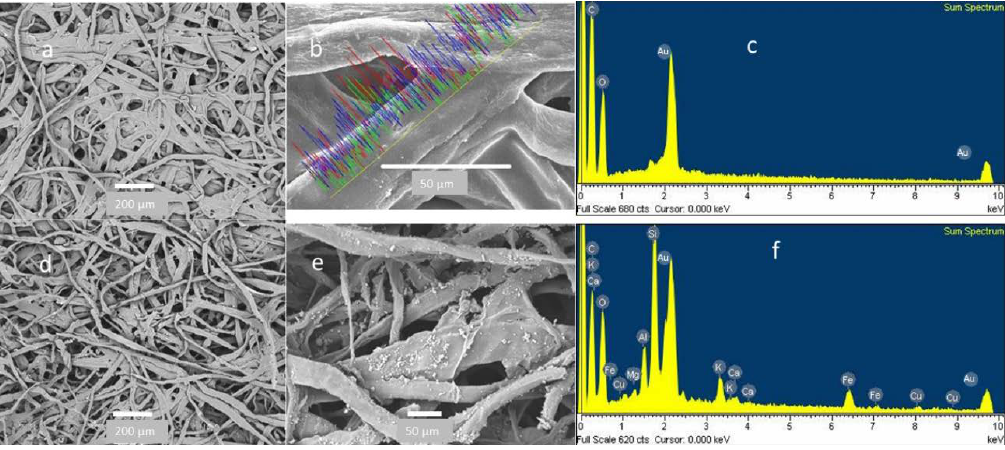
Figure 6. ( a–c ) Scanning electron micrographs and EDX spectrum of control filters and ( d–f ) collected CAFs.